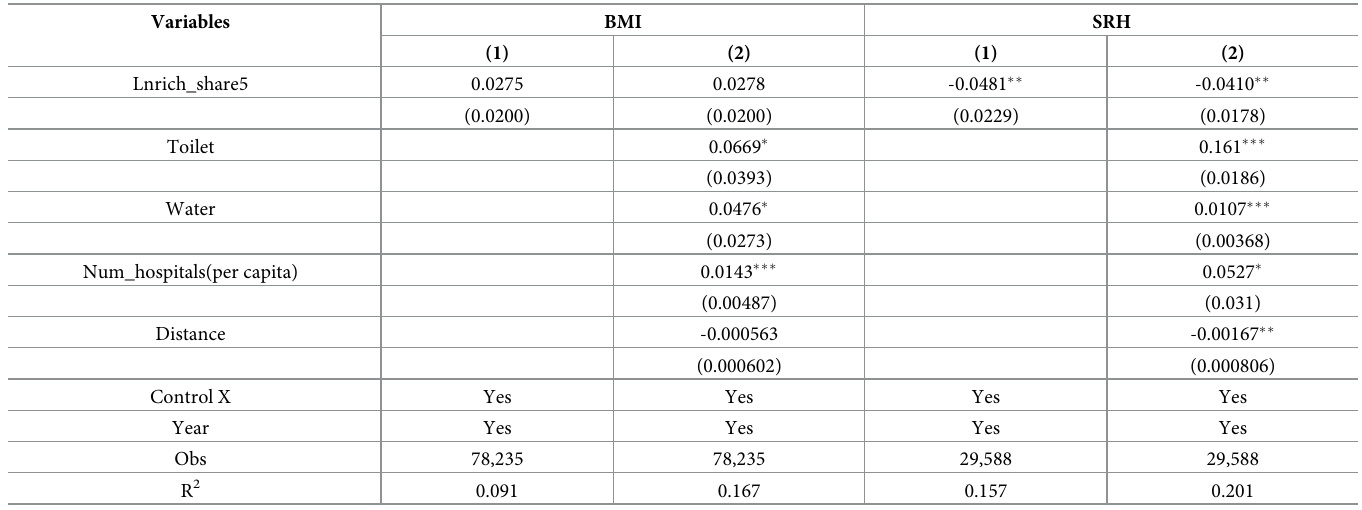
Table 7. Possible channels of influence of income inequality.